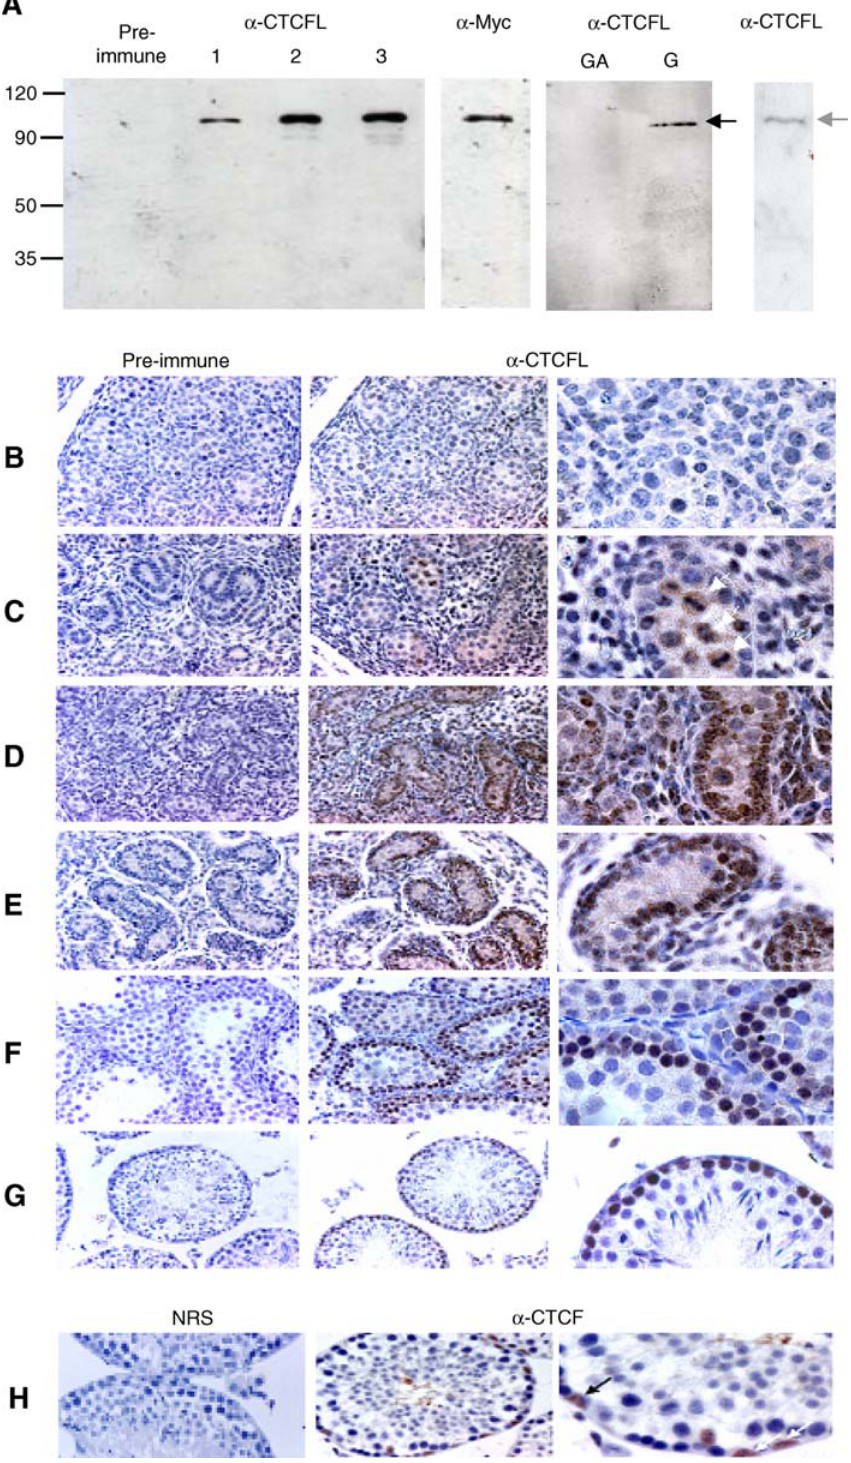
Figure 1. Immunohistochemistry of CTCFL Expression in Developing Testis (A) Characterization of a -CTCFL antibody. Myc-tagged CTCFL expressed in 293T cells was used to assess antibody titer and specificity. First (left) panel shows different anti-sera (dilution 1:1,000); pre-immune; 1: first bleed; 2: second bleed; 3: final bleed. Second panel: verification of myc-tagged CTCFL by a -myc antibody. Third panel: determination of a -CTCFL antibody specificity. The a -CTCFL antibody (dilution 1:10,000) was pre-incubated with GST-N- terminal CTCFL (GA) and GST (G). The antibody, pre-incubated with specific antigen, was neutralized, whereas a -CTCFL pre-incubated with GST alone retained its reactivity. Fourth panel: a -CTCFL reacted with a Western blot of adult testis extract. The black arrow indicates the position of myc epitope- tagged CTCFL, whereas the grey arrow indicates the position of endogenous CTCFL. (B–G) CTCFL expression in developing and adult testis. The pre-immune and adjacent a -CTCFL panels are at the same magnification (400 3 ). A 5 3 magnification of the a -CTCFL image is given in the rightmost panel.